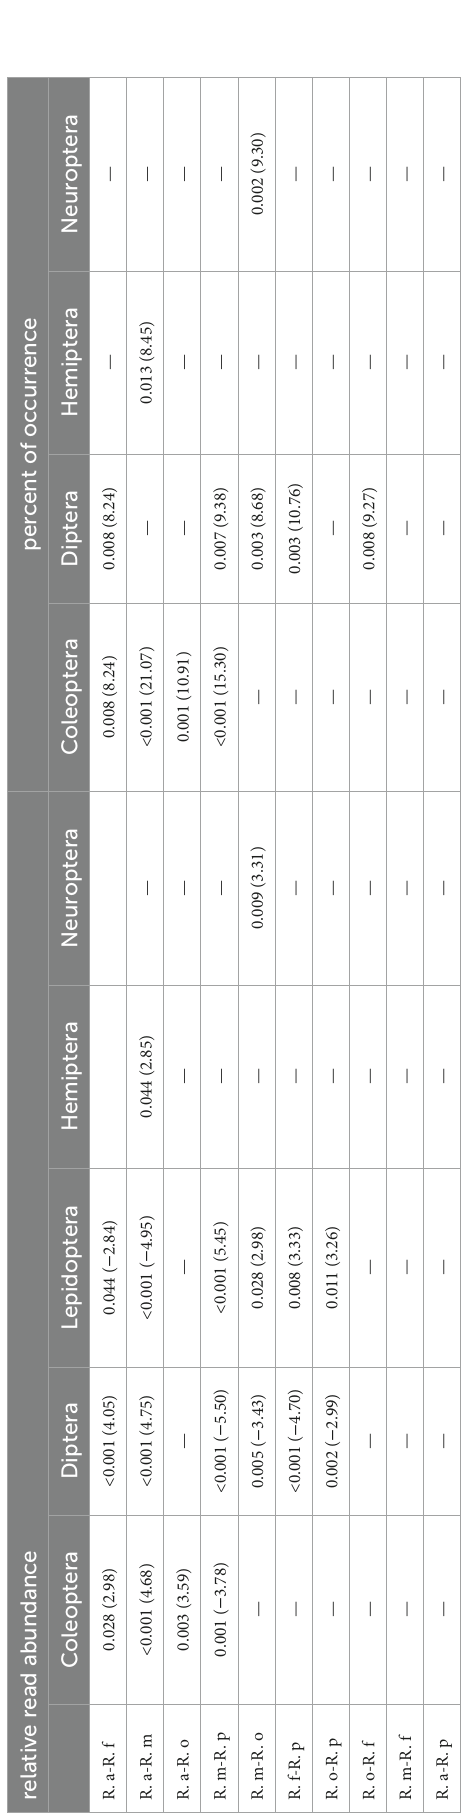
The NMDS ordination of diet composition between groups of five rhinolophid bats resulted in a two-dimensional solution with final stress of 0.103. The samples obtained from the five rhinolophid bats were spread out in the diagram, and the ANOSIM analysis showed significant differences in dietary composition in all pairwise comparisons (Figure 4A; r = 0.17, p = 0.001), except between R. affinis and R. pusillus ( r = 0.09, p = 0.07). Because all factors had VIF values of less than 10 (Table 4), all factors were added to the model. The results of the CCA showed a significant relationship between all factors and diet data (adjusted r 2 = 1.63%, p = 0.001; Table 4; Figure 4B), and the results of the permutations tests for each influencing factor individually showed that body weight, forearm length, peak frequency were all significantly correlated with dietary composition ( p < 0.05; Table 4; Figure 4B). Hierarchical partitioning analysis showed that echolocation calls (peak frequency) were the most important factors, followed by body size factors (forearm length and body weight), while parameters such as wing loading and bite force had no significant effect on the diet composition structure for each bat species (Table 4; Figure